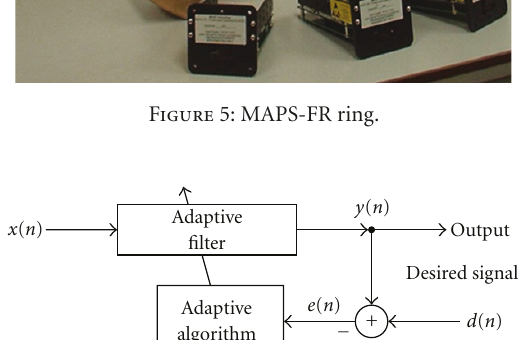
Figure 8: Pure MAPS-FR signals aims to estimate the riser load. However, better results are achieved when the four signals are combined by the proposed